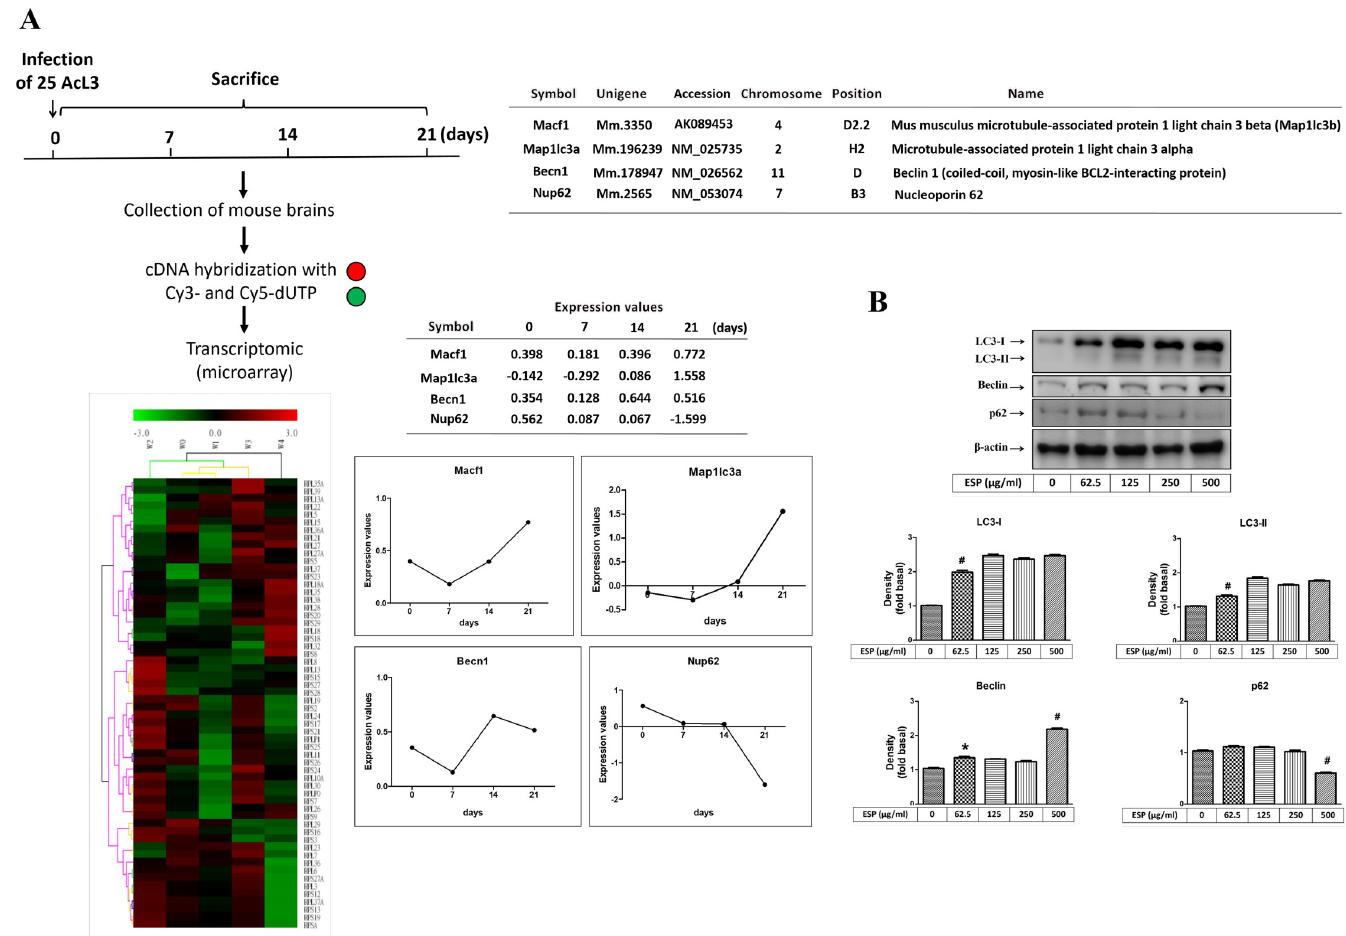
Fig 2. Excretory/secretory products of A . cantonensis L5 stimulate autophagy in astrocytes. (A) Mouse brains were collected from A . cantonensis -infected mice on days 0, 7, 14, and 21 postinfection. Then, the mRNA expression levels of autophagy-related molecules were detected by cDNA microarray analysis. (B) Cells were treated with 0, 62.5, 125, 250, and 500 μ g/ml A . cantonensis L5 excretory/secretory products (ESPs) for 12 h. The protein expression levels of autophagy-related molecules were detected by Western blotting. The data are expressed as the means ± SD from three independent experiments ( n = 3). � P < 0.05, # P < 0.01, compared with the respective values of cells treated with 0 μ g/ml A . cantonensis L5 ESPs for 12 h.